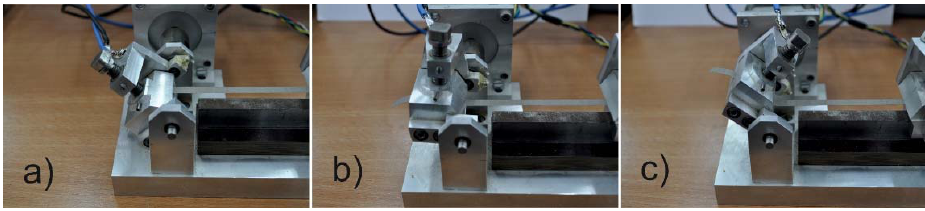
Figure 5. Stages of the bending process.